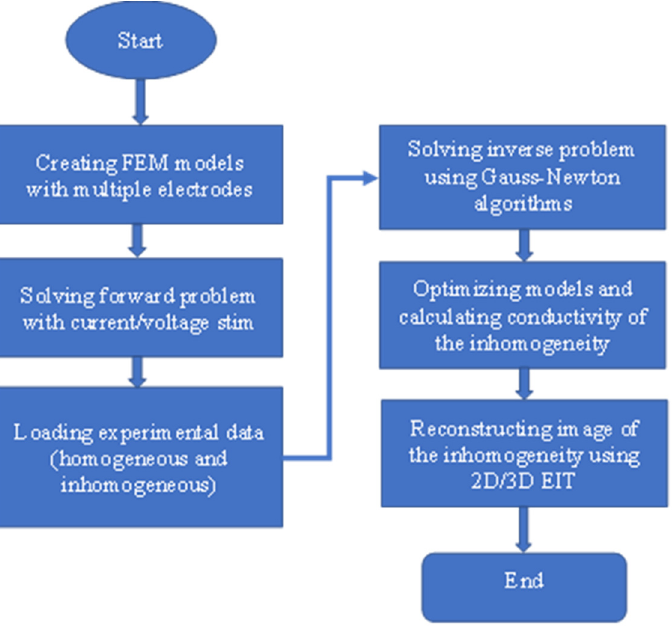
Figure 4. Flowchart of EIDORS operation. The common EIT inverse algorithms for FEM modeling are Gauss–Newton (GN), Shefield back-projection (BP), and total variation (TV), respectively [10,19,34]. The